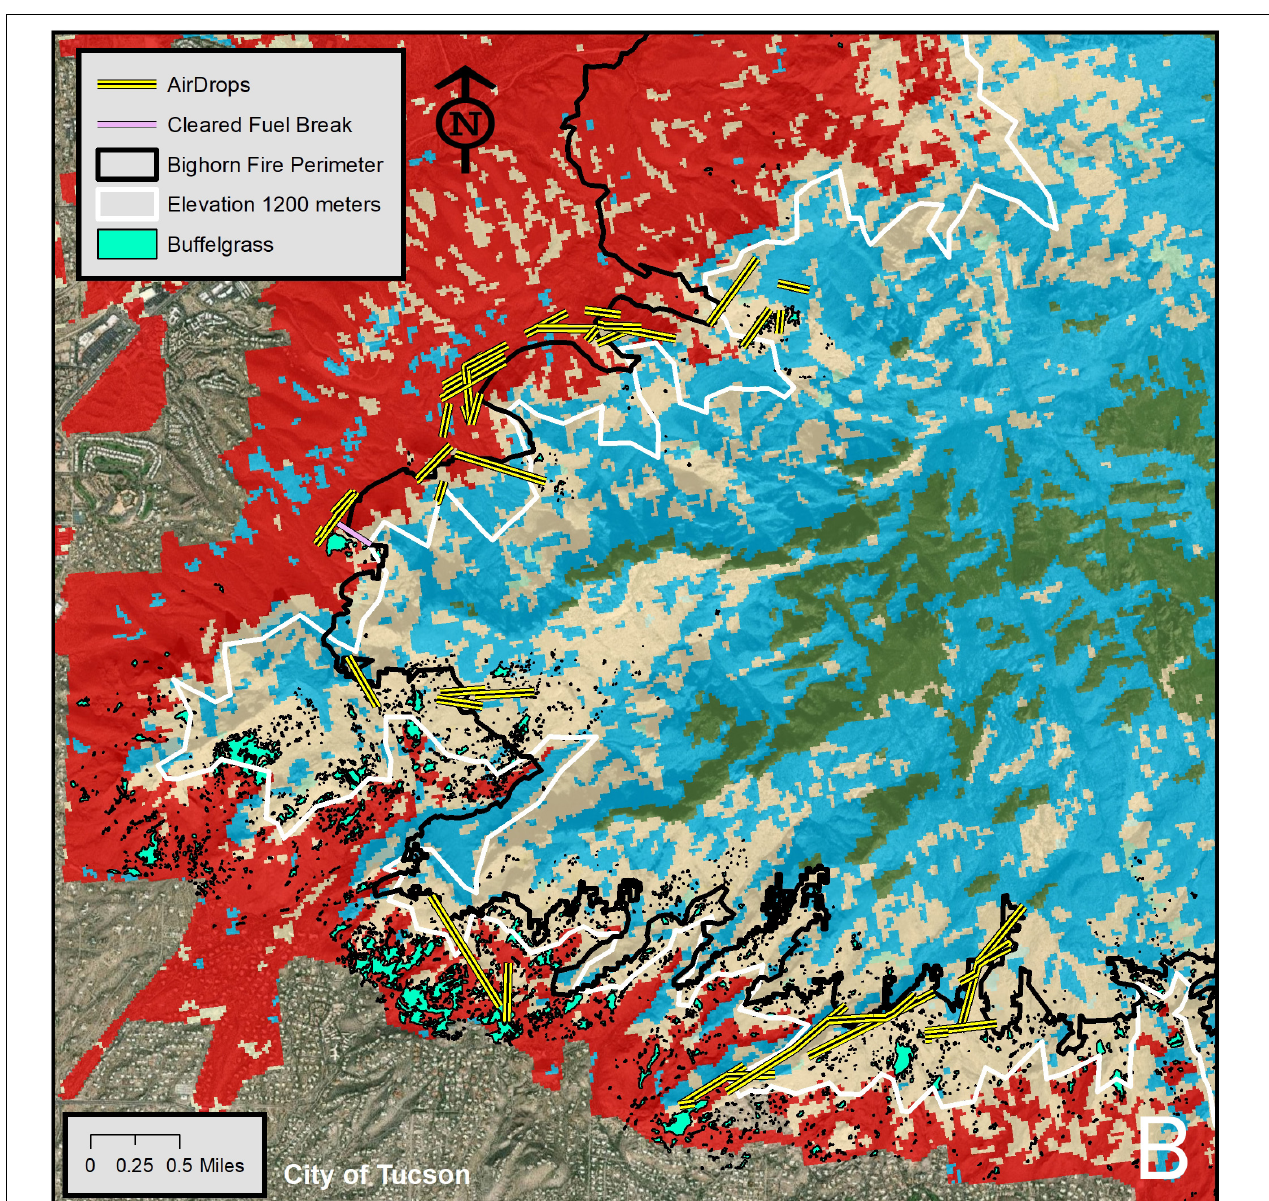
FIGURE 3 | The Santa Catalina Mountains and the Bighorn Fire perimeter. (A) The Catalina Mountains and ecosystems. (B) Close up of the southwest portion of the Catalina Mountains and the wildland-urban interface with present-day buffelgrass infestation, Bighorn Fire suppression efforts, and the 1,200 masl Desertscrub/Semi-desert Grassland